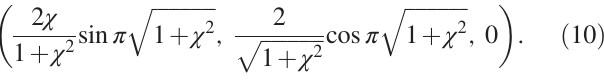
¼ 0 ( i.e. , μ ¼ π ), 2